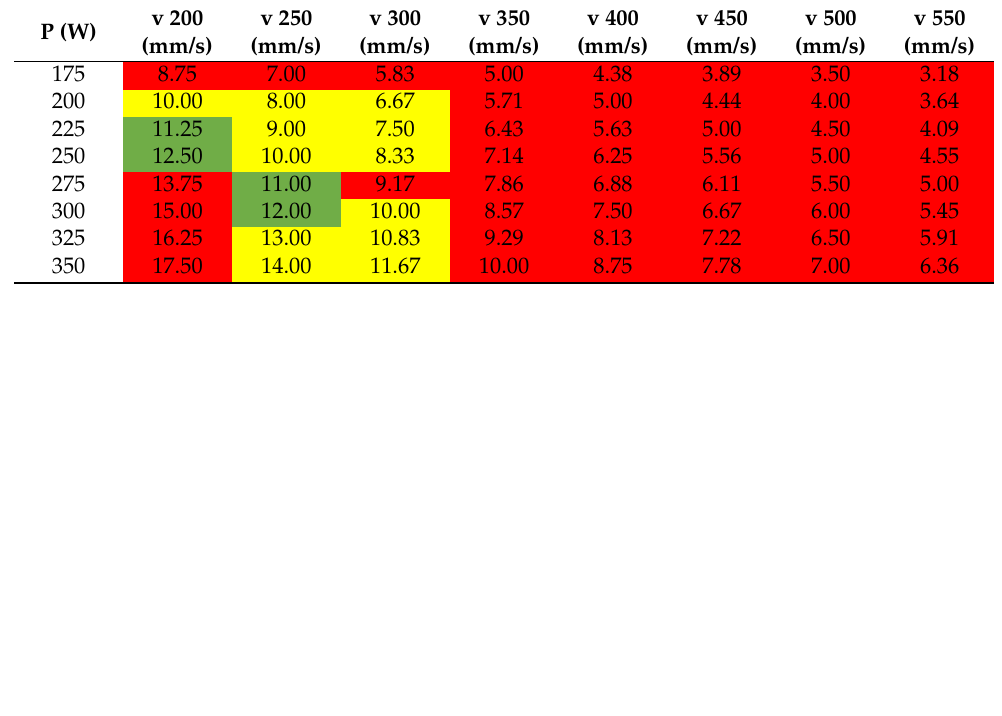
Figure 8. ( a ) Weld inhomogeneity P = 200 W, v = 550 mm/s; ( b ) Spatters of molten weld material P = 275 W, v = 275 mm/s.